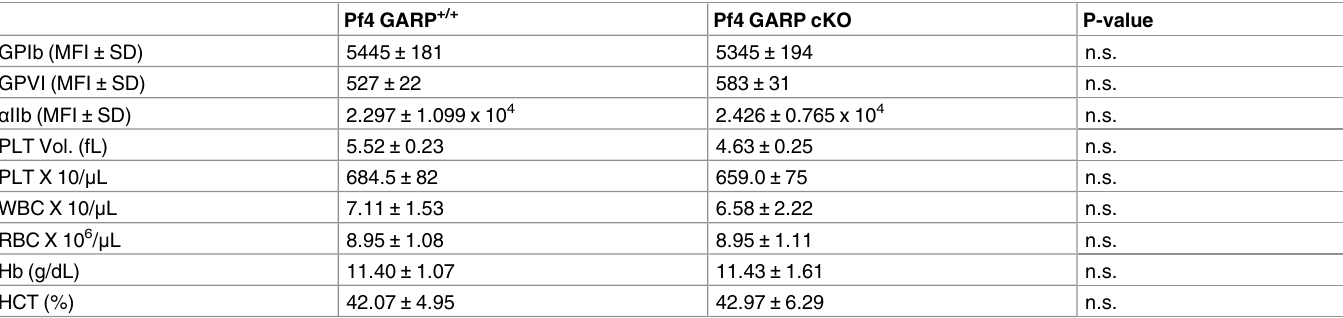
Platelet receptors are quantified as mean fluorescence intensity (MFI) ± SD; n = 3; Platelet volume (PLT Vol.); platelet (PLT); white blood cell (WBC)and